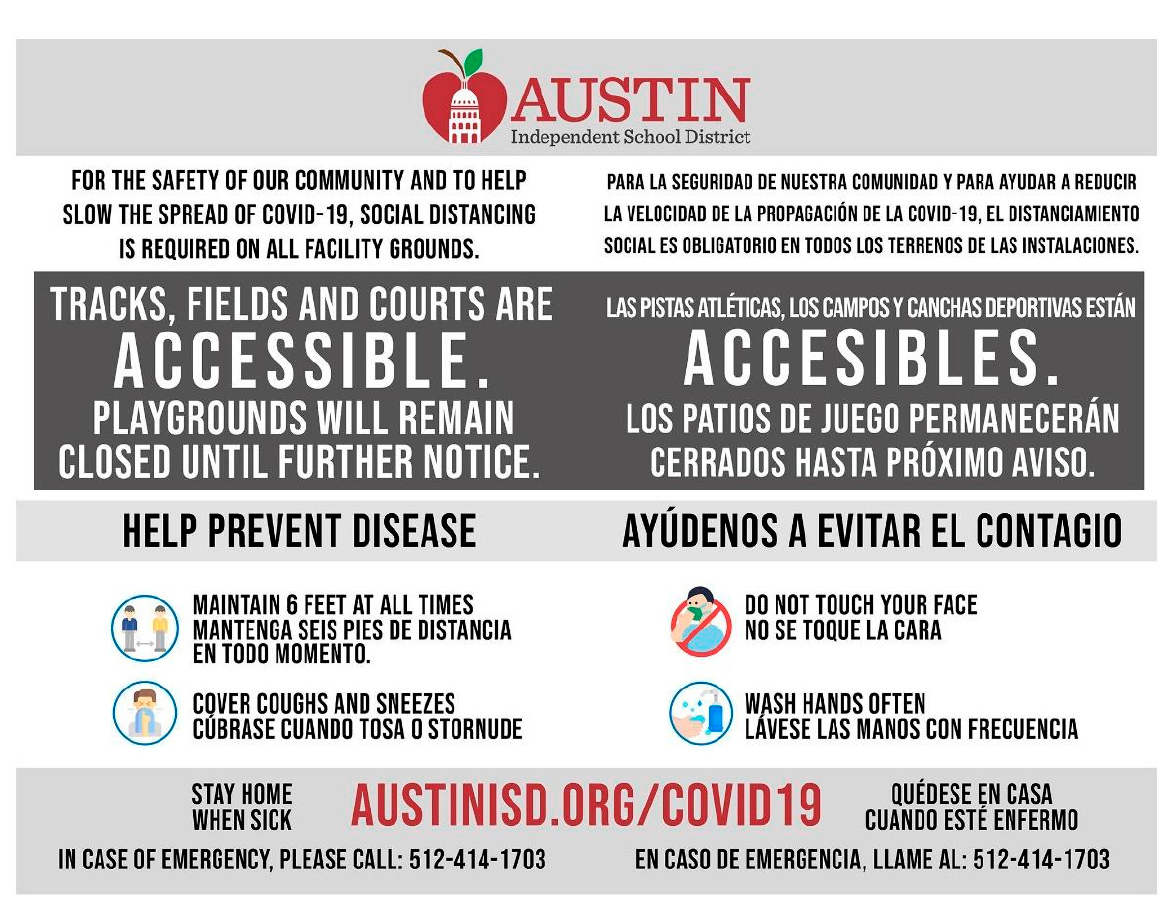
Figure A1. Signage of COVID-19 requirements installed at joint-use parks in Austin, TX, USA.